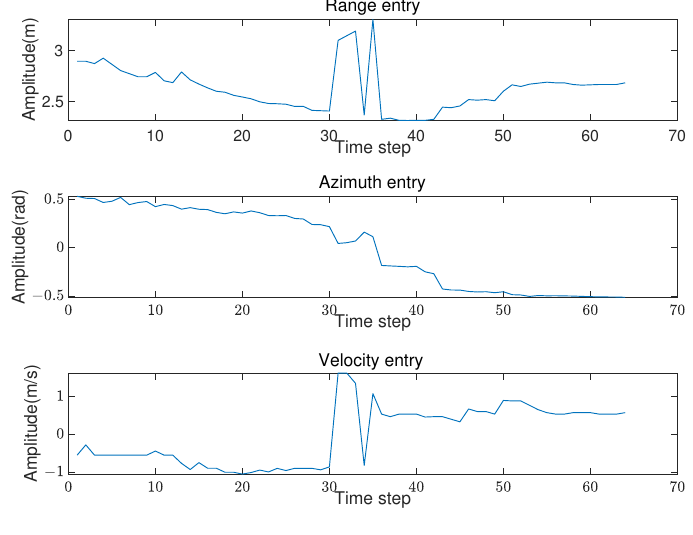
Figure 11. Raw data plots in three-dimensional entries in the measurement vector.